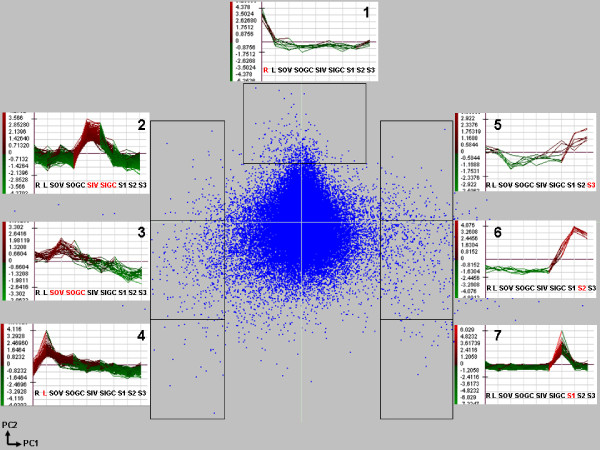
Principal component analysis (PCA) of microarray data and representative K-means profiles of tissue-specific gene expressions. Variance of principal component 1 (PC1) = 41.05% and of principal component 2 (PC2) = 17.73%. Three major regions of dispersion were found representing A) root specific genes (profile 1); B) stem specific genes (profiles 2 and 3) and leaf specific genes (profile 4); and C) seed specific genes (profiles 5, 6 and 7). Genes similarly expressed in different tissues are located in the middle of the PCA figure. R: root; L: leaf; SOV: Shoot outer tissue, vegetative stage; SOGC: shoot outer tissue, green capsule stage; SIV: Shoot inner tissue, vegetative stage; SIGC: shoot inner tissue, green capsule stage; S1: 10-15 days-old seeds; S2: 20-30 days-old seeds; S3: 40-50 days-old seeds.